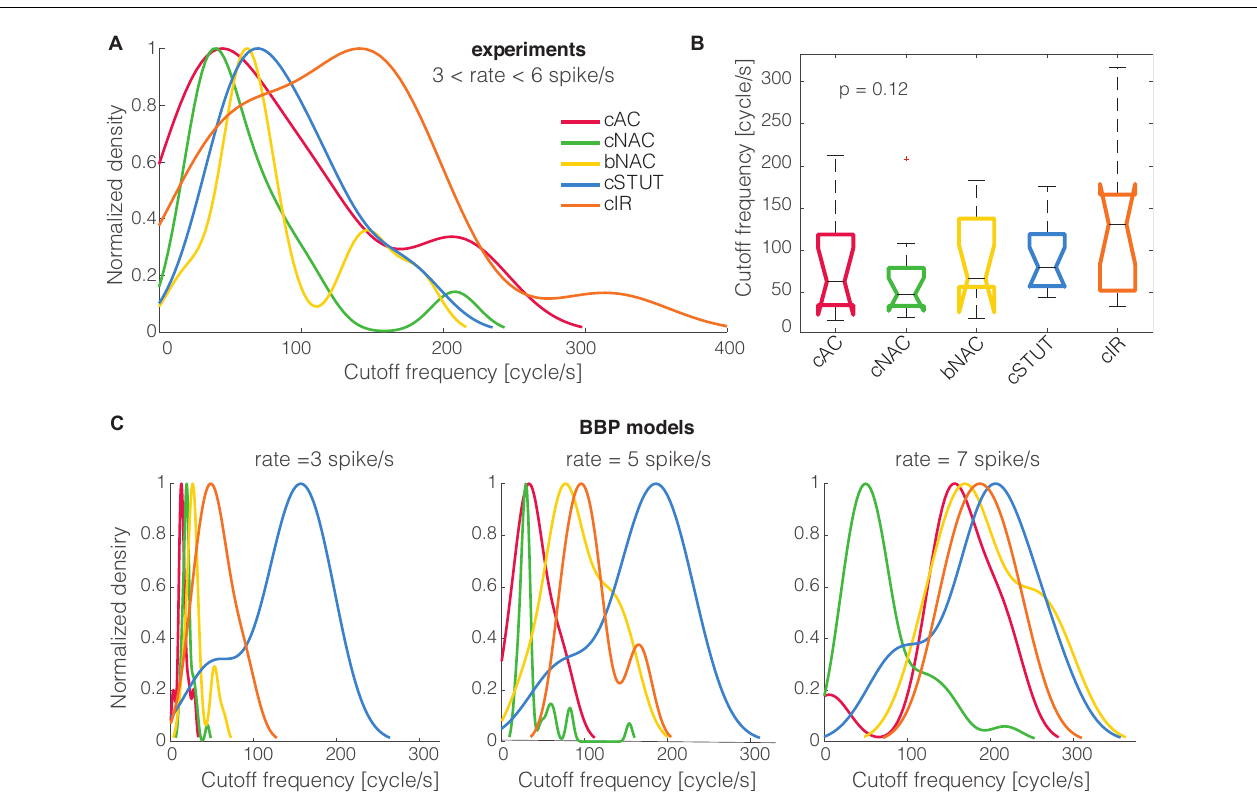
FIGURE 3 | The cells’ electrical phenotype and cut off frequency distributions. When the five distinct electrical classes of L1 interneurons were compared to each other, their (smoothed) probability density distributions of the cut off frequencies, normalized by their peak values, showed no major differences (A) . Quantitatively, the Kruskal–Wallis statistical test failed to reject, at 1% significance level, the null hypothesis that the cut off frequencies come from the same distribution (B) . A similar trend was largely reproduced in silico for the BBP models (C)